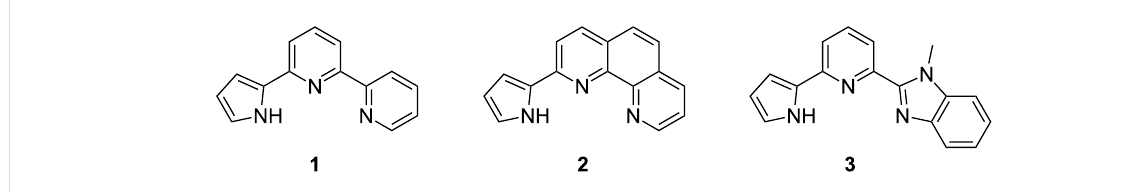
Scheme 2: Pyrrole–pyridine-based structures synthesized in this study.